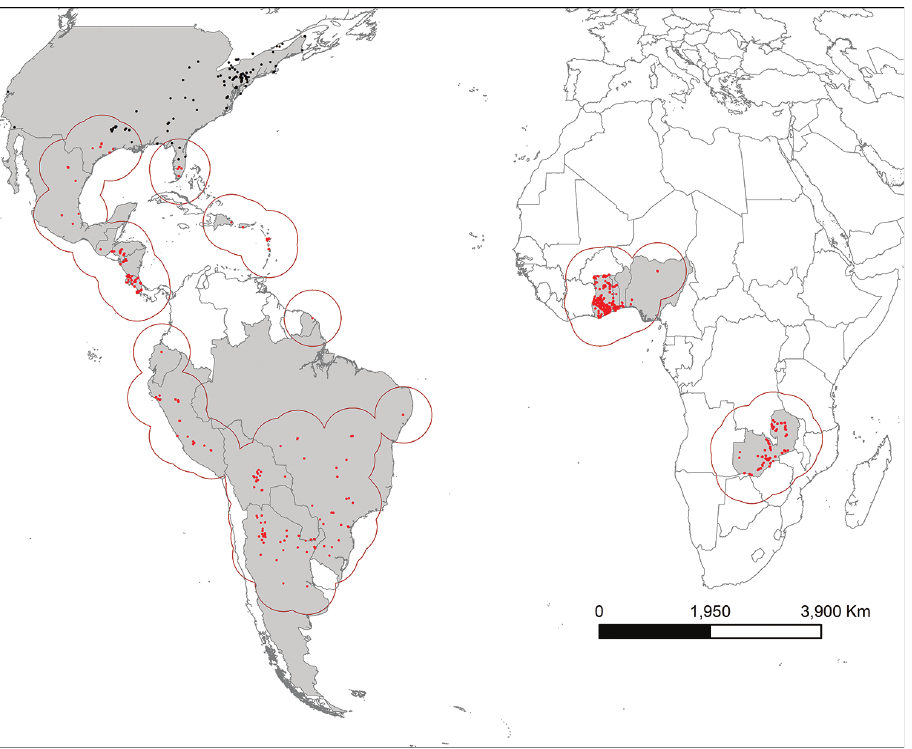
Figure 1. Fall armyworm distribution data. Red points are the complete set of presence locations used to make models. Black points in the USA are not part of the year-round native distribution and were not in- cluded in models. Grey areas are the geographically unrestricted background from which pseudo-absences could be drawn. Red lines indicate the geographically restricted background (500 km radius around pres- ence locations) within which pseudo-absences could be